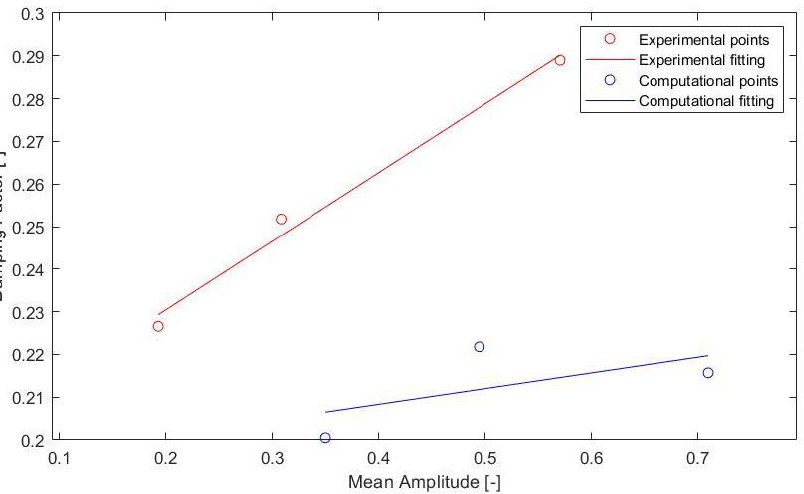
Figure 8. Damping factor comparison with the data from the first periods in order to delete the more significant effect of DoFs that were not unlocked in the computational tests.